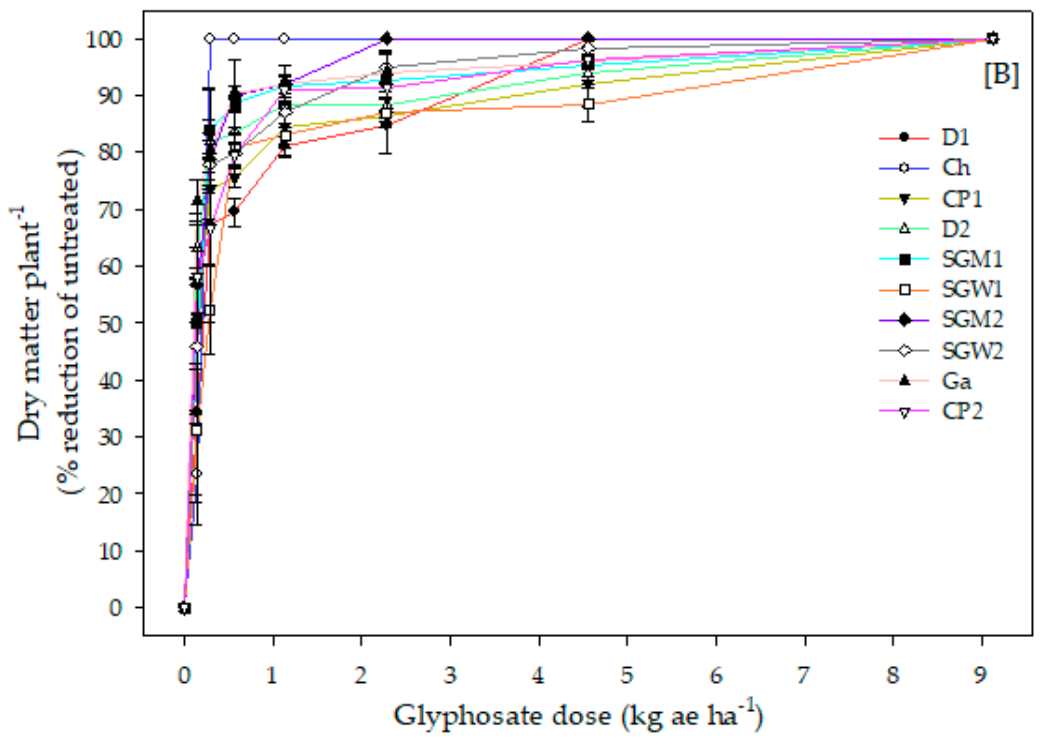
Figure 1. Effect of glyphosate doses on survival percentage ( A ) and dry matter plant − 1 (% reduction of untreated) ( B ) of 10 biotypes of Chloris virgata . Error bars represent the standard error of mean. Glyphosate-susceptible biotypes are Ch and SGM2, and glyphosate-resistant biotypes are SGW2 and CP2.